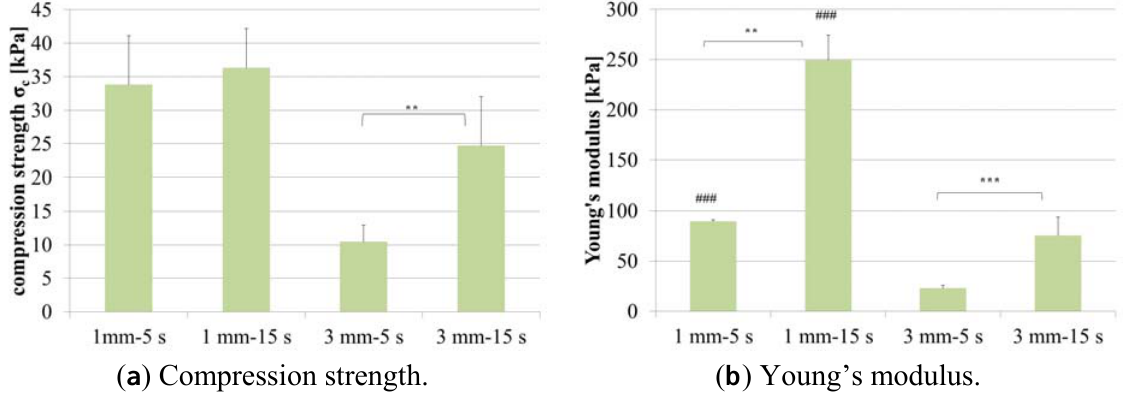
( a ) Compression strength. ( b ) Young’s